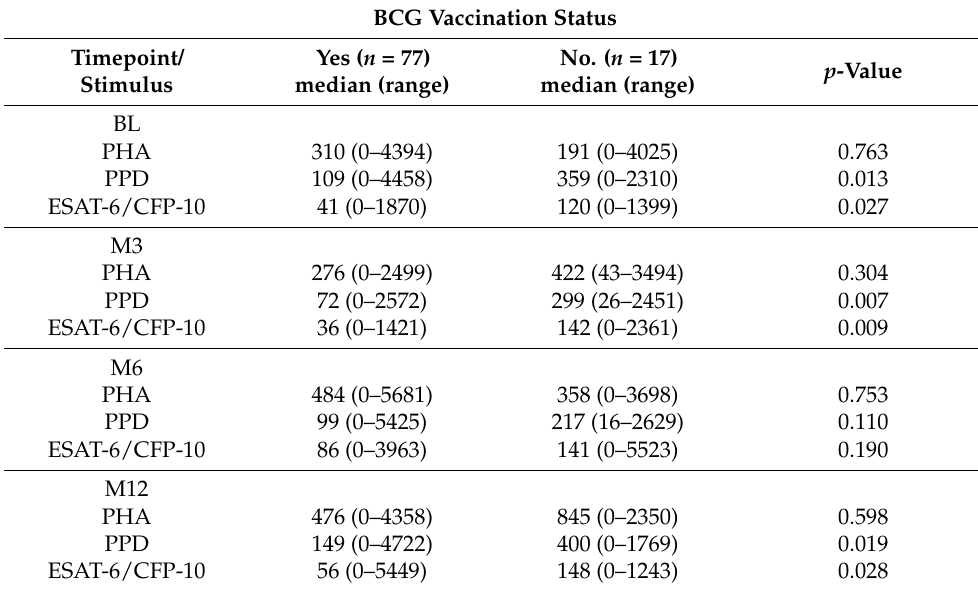
Table 2. IFN- γ concentrations after in vitro restimulation of blood samples from BCG-vaccinated and non-BCG-vaccinated children with M. tuberculosis antigens.